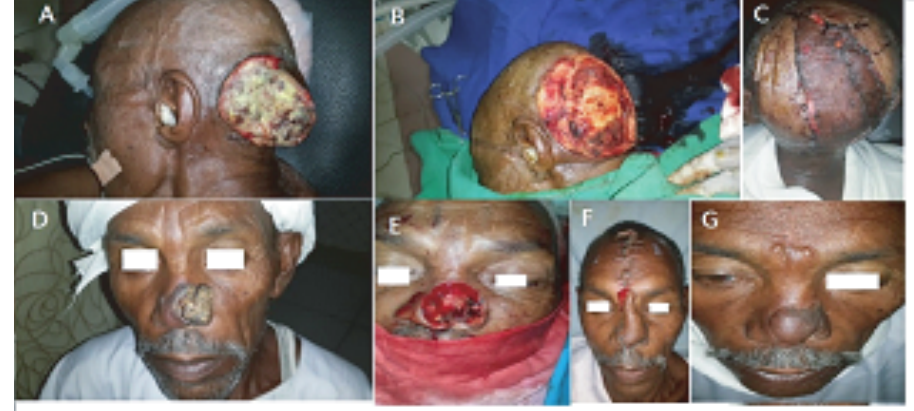
Figure 6 : A, B, and C show squamous cell carcinoma. E, F, G, and H show basal cell